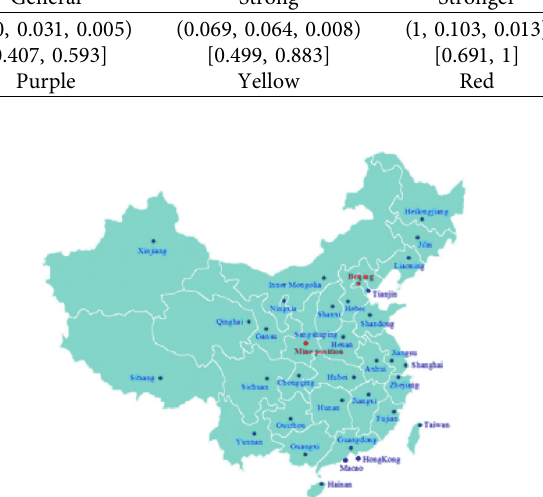
Figure 7: The mine position of test Y coal